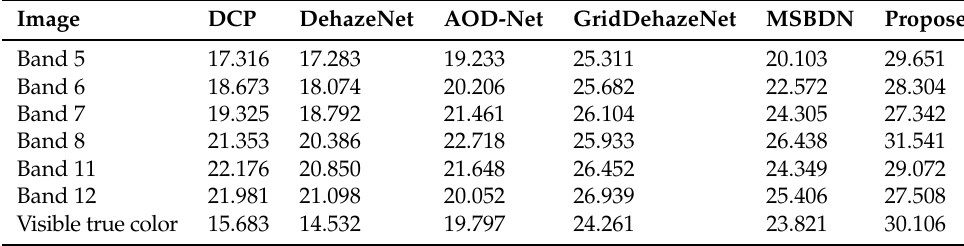
Table 2. Experimental results on different bands: